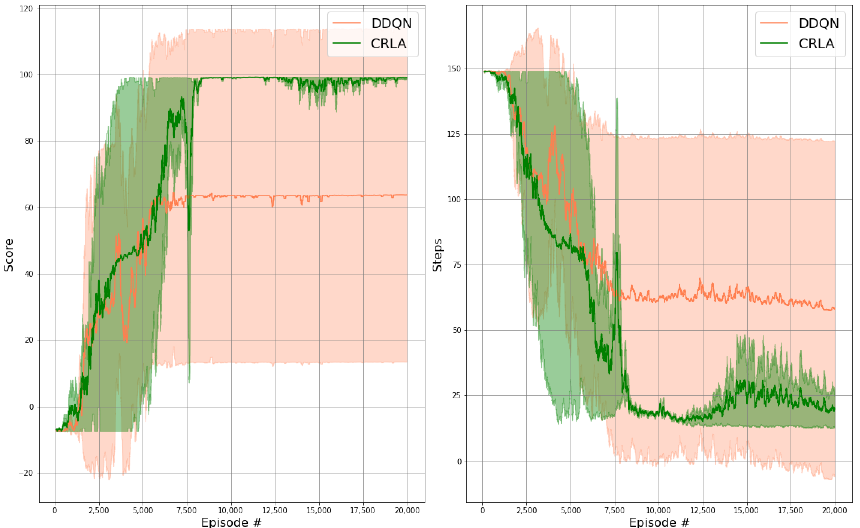
Figure 6. Results of CRLA and single-agent DDQN on a maze scenario with 4096 actions. Left panel: the cumulative scores throughout the training. Right panel: the required number of steps to capture the flag throughout the